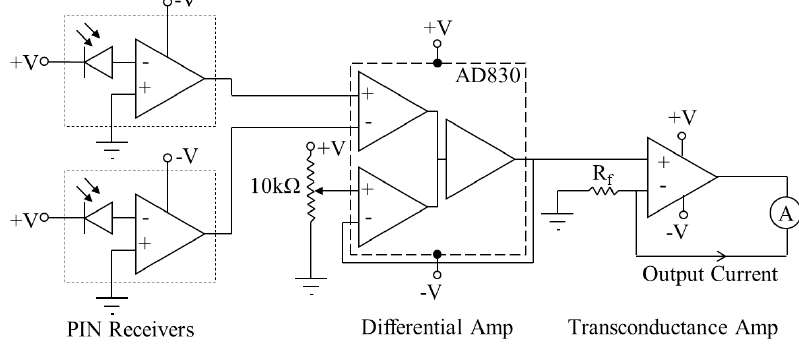
Figure 7. Schematic of the PLC Fibre Optic Sensor (FOS) analogue input interface, including the receivers, differential amplifier and transconductance